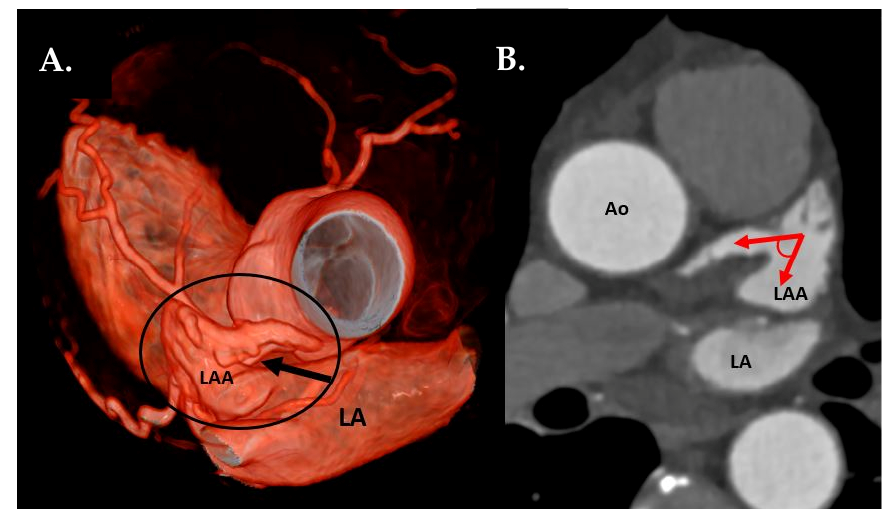
Figure 2. ( A ) CTA 3D-VRT reconstruction of LAA with a sharp tip angulation ( ≤ 90 ◦ ) (black arrow). ( B ) sagittal plane with red arrows delineating sharp LAA tip angulation. Ao—aorta, LA—left atrium, LAA—left atrial appendage.